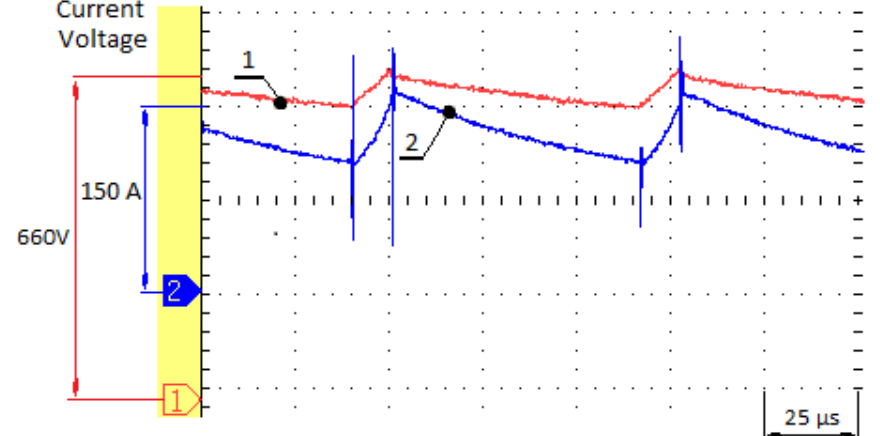
Figure 17. Boost mode of operation. 1–drain-to-source voltage, Buck transistor Q1, and 2–current through the transistor Q2 during Boost mode of operation.